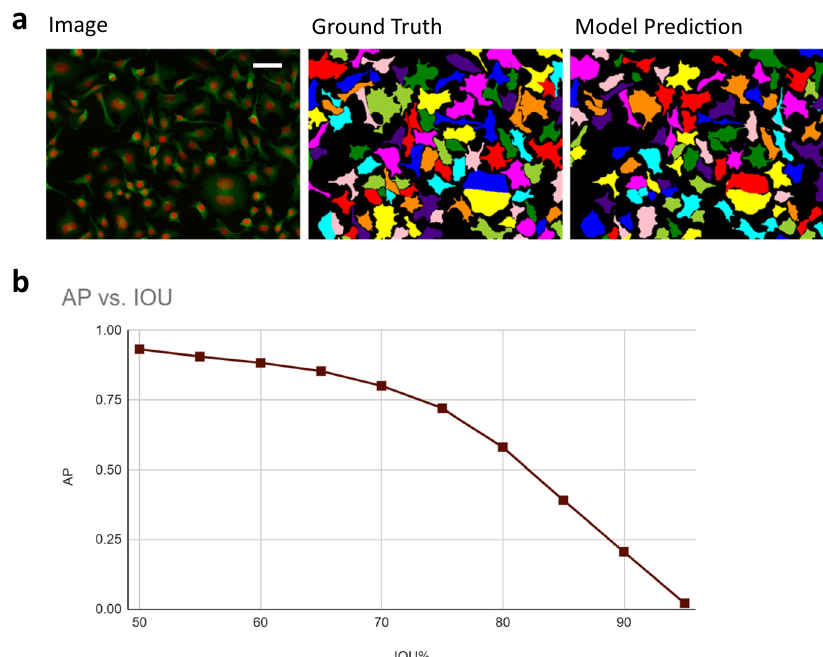
Fig. 3 Segmentation of cell image library dataset with a LACSS model trained with incomplete annotations. a A representative example of segmentation results showing the input image (left), the ground-truth segmentation (middle) and model prediction (right). The pseudo colors were generated via skimage ’ s label2rgb function for visual clarity and carried no extra meaning. b Model performances quanti fi ed by average precisions and false negative rates at various IOU thresholds. Scale bar represents 50 micrometers.